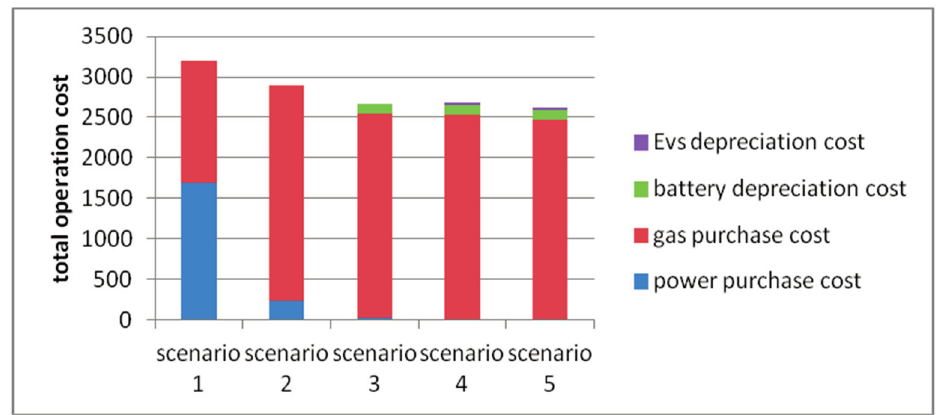
Figure 3. The micro grid operation costs in different modes.